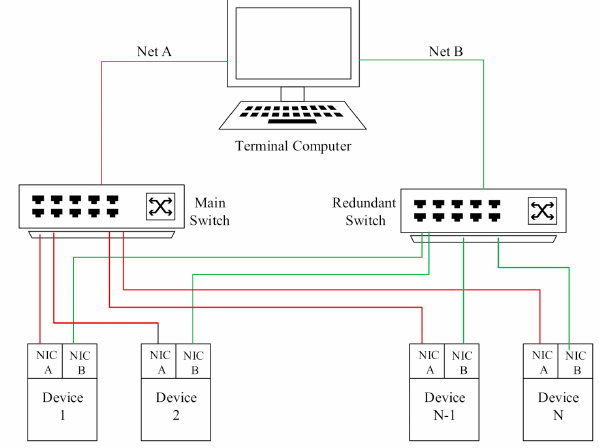
Figure 9. Topology structures of dual-redundant